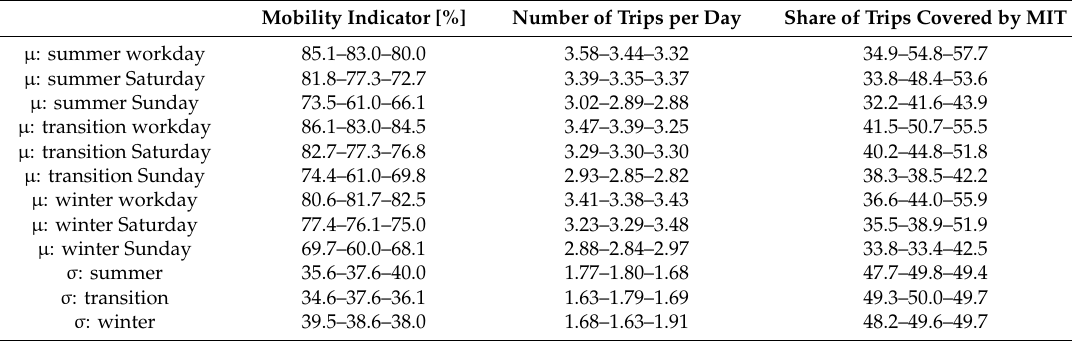
Table A2. Mean ( µ ) and standard deviation ( σ ) of the standard normal distribution considering the mobility indicator, the number of trips per day as well as the share of trips covered by motorized individual transport (MIT) depending on season, weekday and grid region (urban–suburban–rural) [66]. Mobility Indicator [%] Number of Trips per Share of Trips Covered by Day MIT